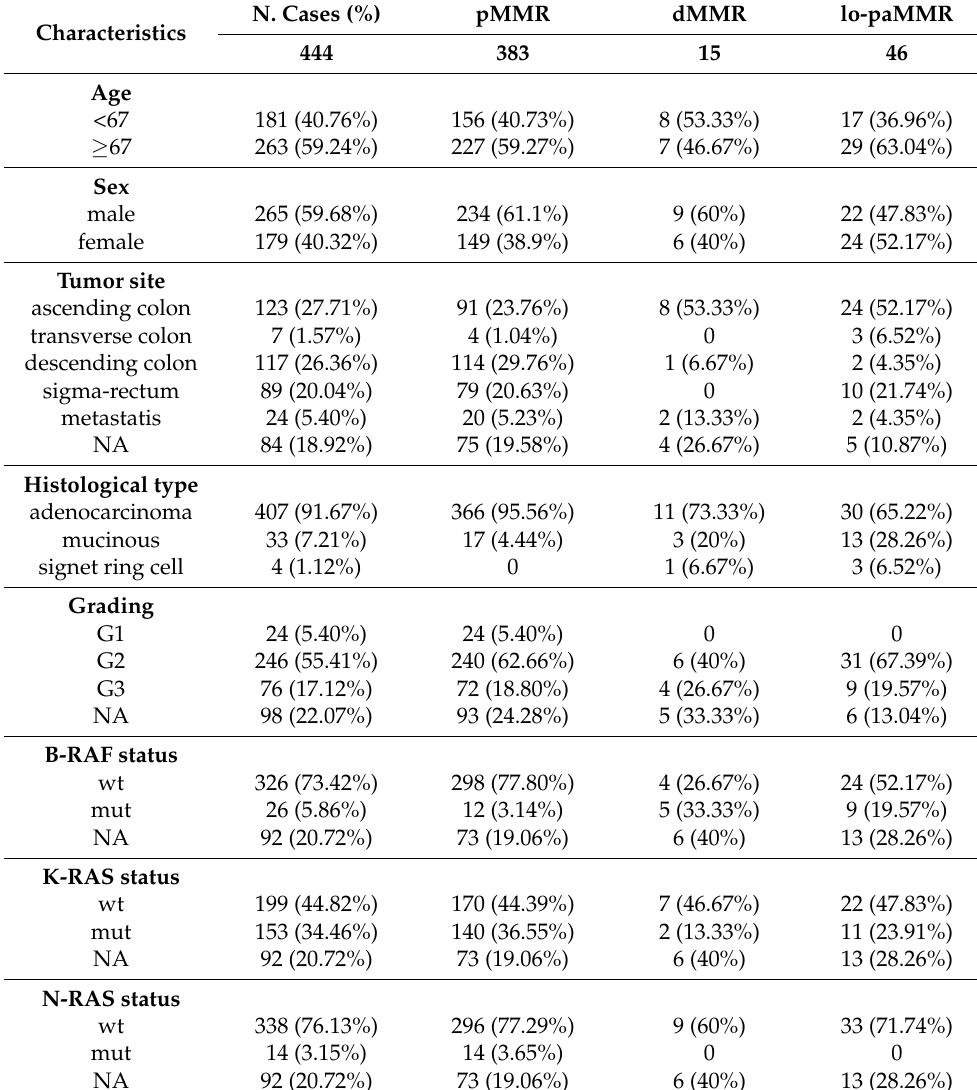
Table 1. Clinical and pathological features of CRC